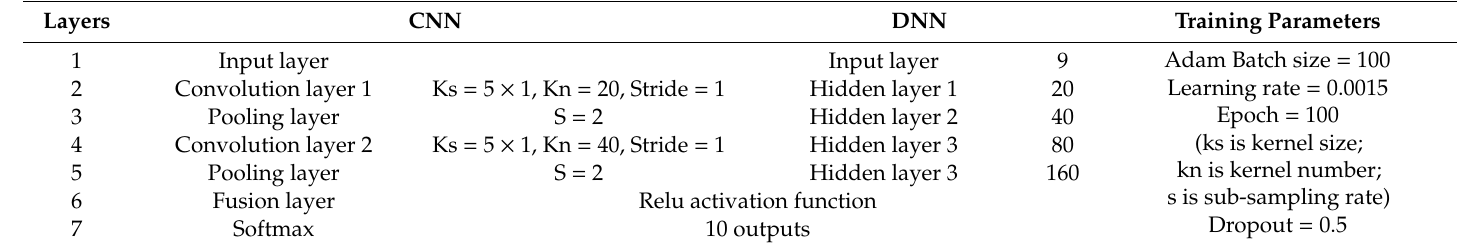
Figure 3. Schematic diagram of the proposed model CNNEPDNN. Table 1. CNNEPDNN